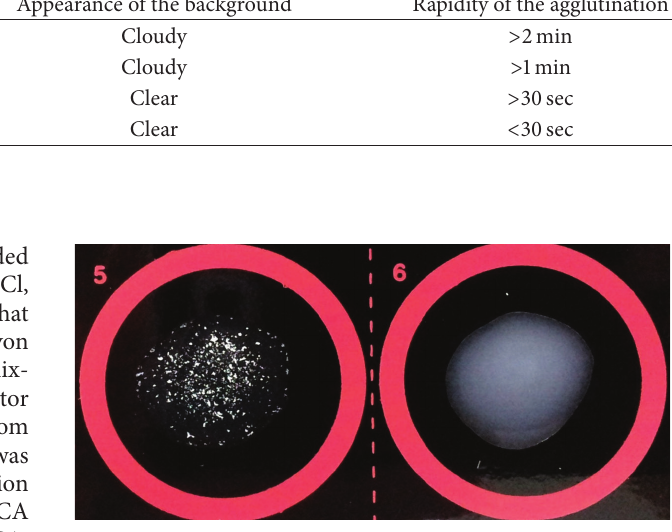
Figure 1: Positive (number 5) and negative (number 6) reactions of qualitative latex agglutination test for VWF :